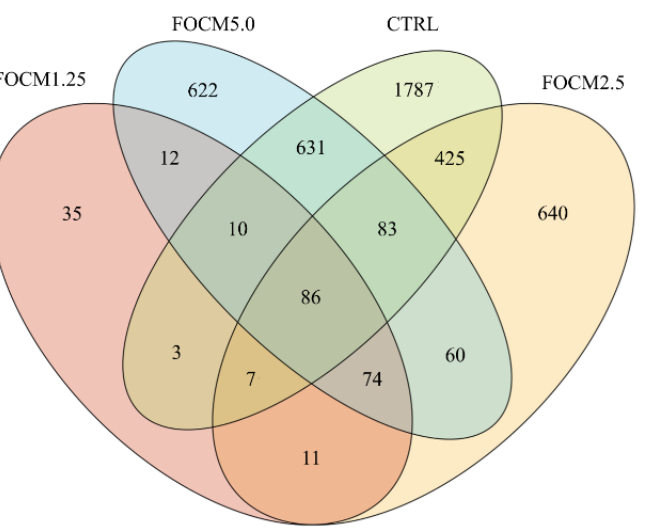
Figure 5. Venn diagram of observed OTU distribution at 97% similarity in each sample group. CTRL: basal diet; FOCM1.25: basal diet plus 1.25% of FOCM; FOCM2.5: basal diet plus 2.5% of FOCM; FOCM5.0: basal diet plus 5.0% of FOCM. Data are mean values of three replicates per treatment. Table 7. The alpha diversity indices of ileal microbiota in 21-day-old broilers. CTRL 1